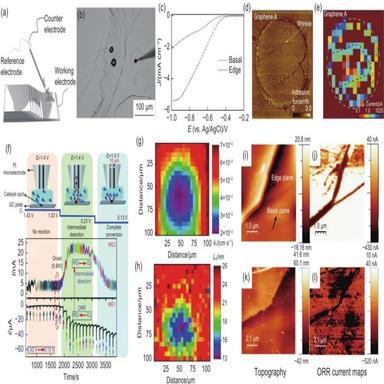
a) Scheme and the (b) optical photograph of the SECCM measured on the HOPG, (c) ORR linear sweep voltammetry curves within a droplet on the edge and the basal region of the HOPG. Reproduced with permission. Copyright @ 2014 Wiley-VCH GmbH. (d) Atomic Force Microscope (AFM) and (e) SECCM current density image of the graphene device of the proton transfer process. Reproduced with permission.